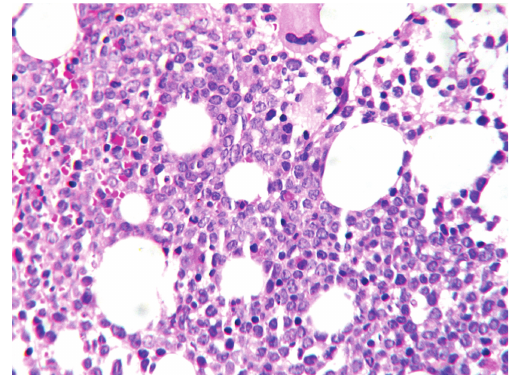
Figure 2: H&E, 40 × . Unremarkable foveolae and glands with expansion of lamina propria by atypical round cells, admixed with granulocytic precursors.